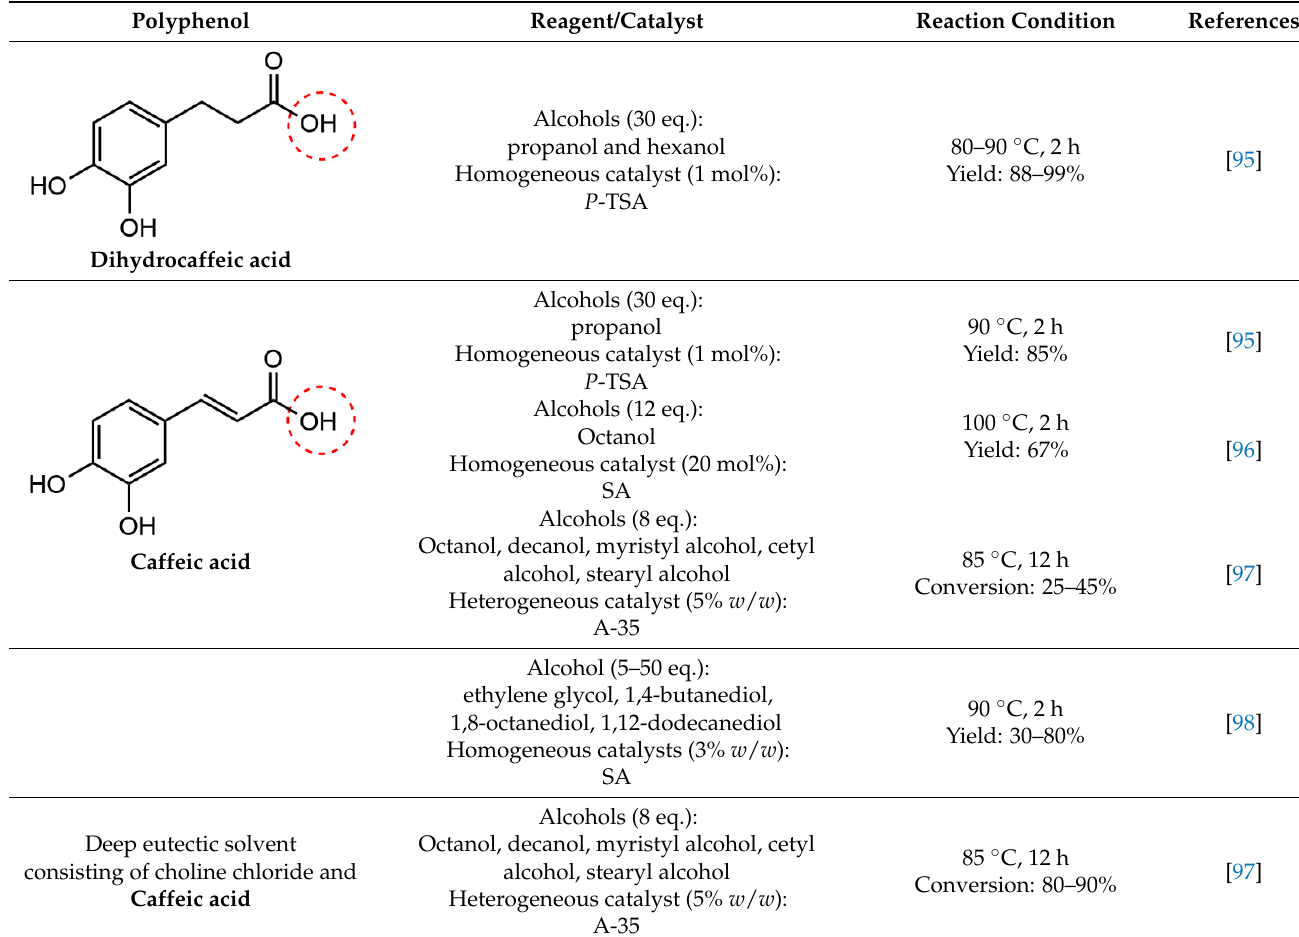
Table 2. Acid-catalyzed synthesis of lipophilic PEs*. Polyphenol